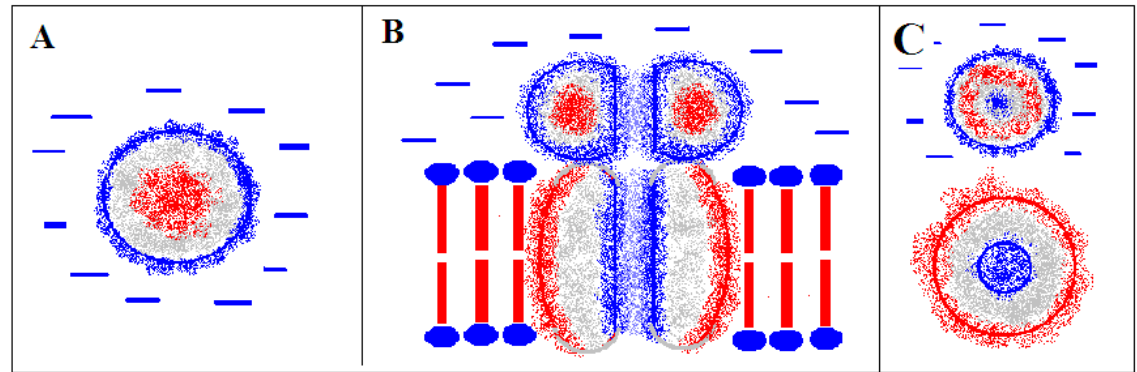
Figure 1. Model of hydrophobicity distribution in. ( A )—globular protein with a hydrophobic core structure of micelle-like type operating in a water environment ( B )—membrane protein, that is, operating in a hydrophobic environment with a centrally located ion channel present (lower domain), the presence of a channel with a polar coat in the domain directed towards the cytoplasm. The red bars represent the hydrophobic fragments of the membrane components, the blue circles— the polar groups of molecules that make up the membrane. ( C )—cross-sections of the two domains of the membrane protein shown in B. Colors used—red—hydrophobicity, blue—polarity, gray—intermediate zone.